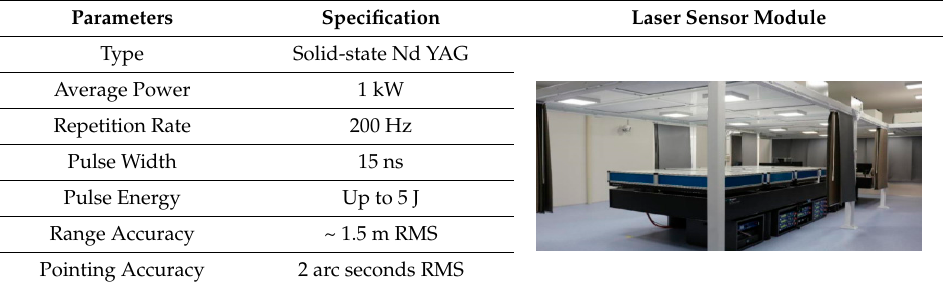
Table 2. The laser tracking sensor specification [15].